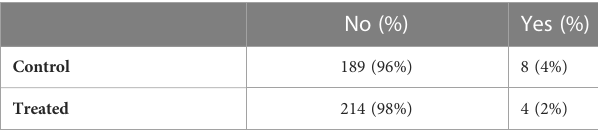
TABLE 3 Number of days without and with a URTI episode in the supplementation